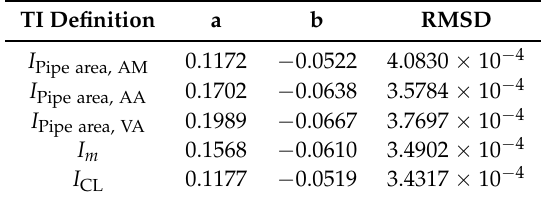
Table 3. Power-law fit constants, rough pipe.